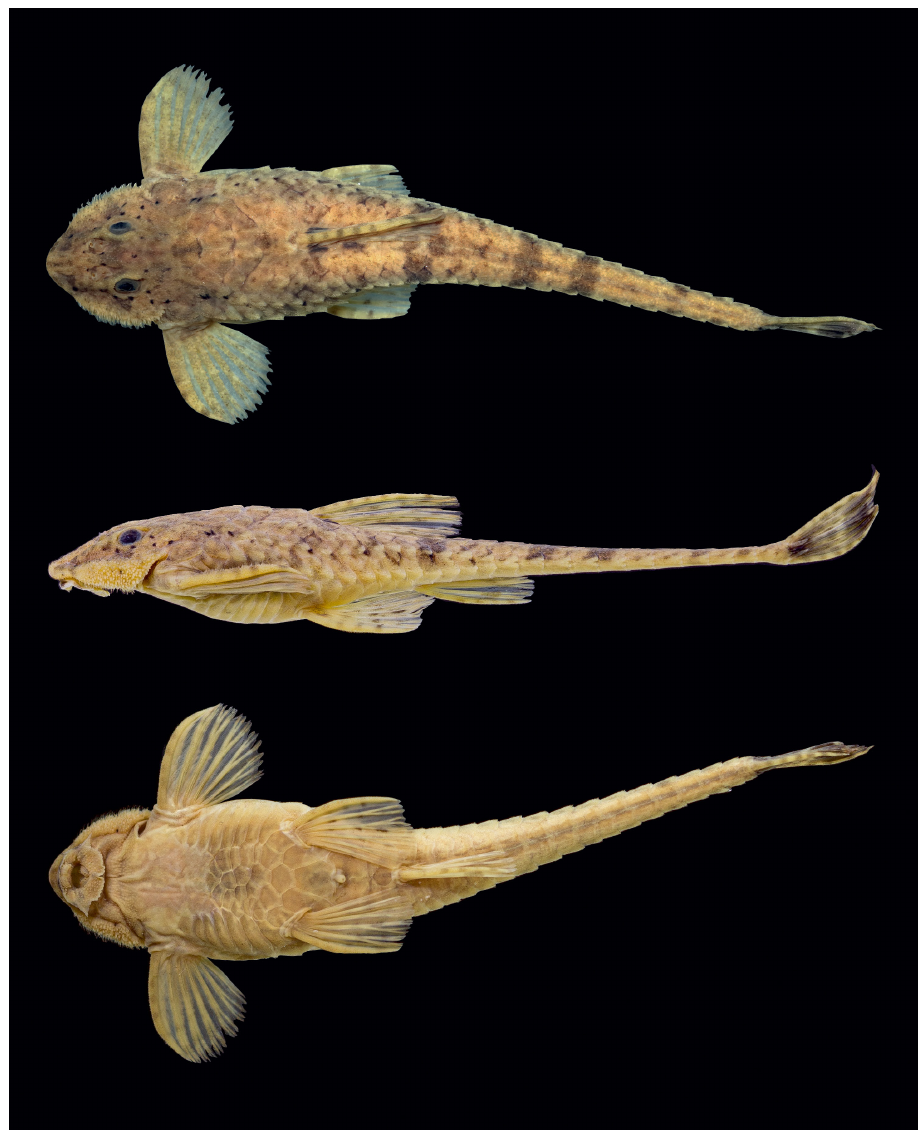
FIGURE 2 | Rineloricaria nudipectoris , holotype, MNRJ 49345, male, 88.8 mm SL, Brazil, Cachoeiras de Macacu, rio Macacu; dorsal, lateral, and ventral